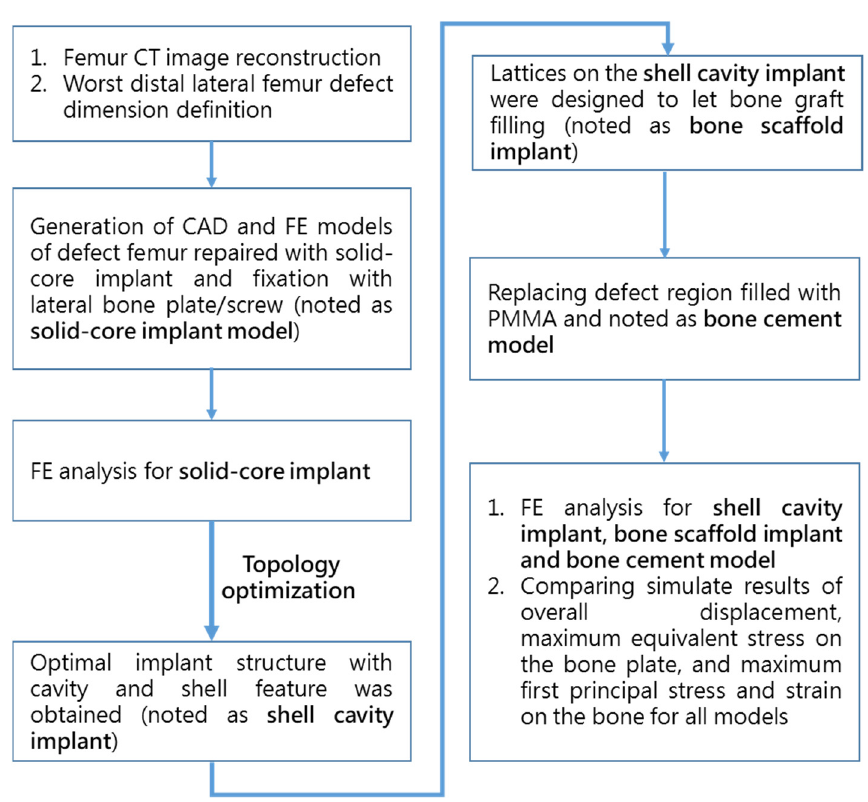
Figure 2. Flowchart of the sequence of FE analysis and in vitro biomechanical testing.